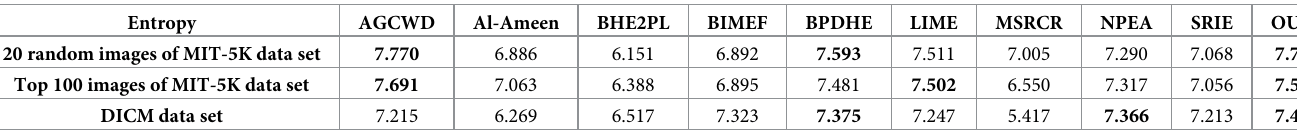
Table 8. Average Entropy of three groups of